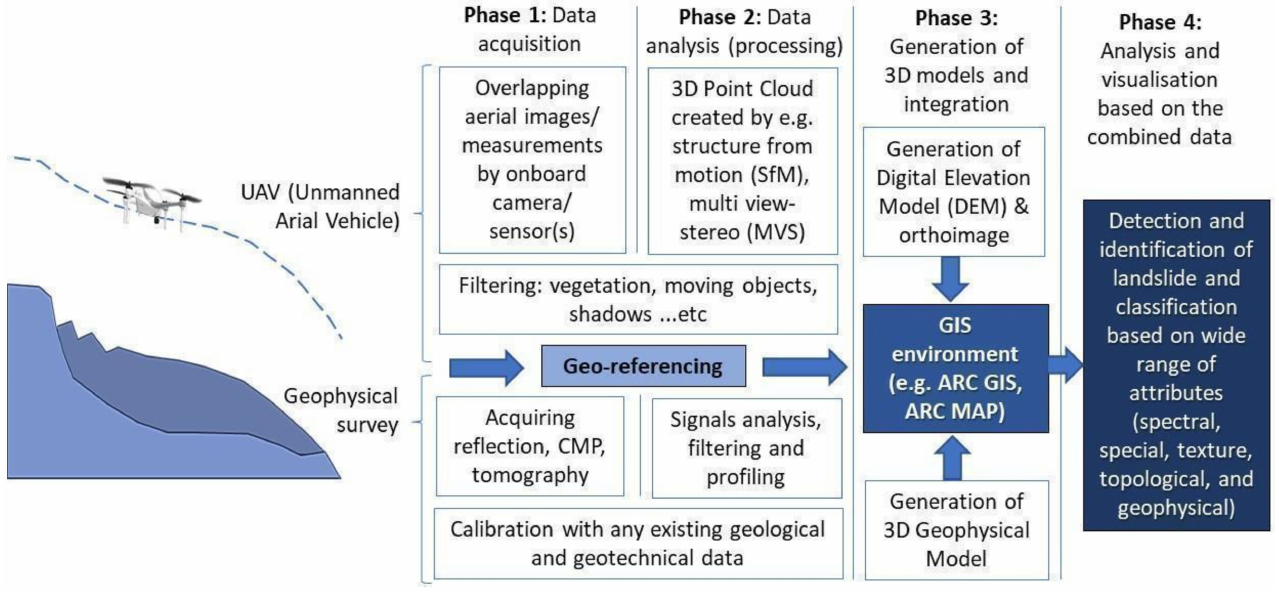
Figure 11. Workflow of the proposed methodology and